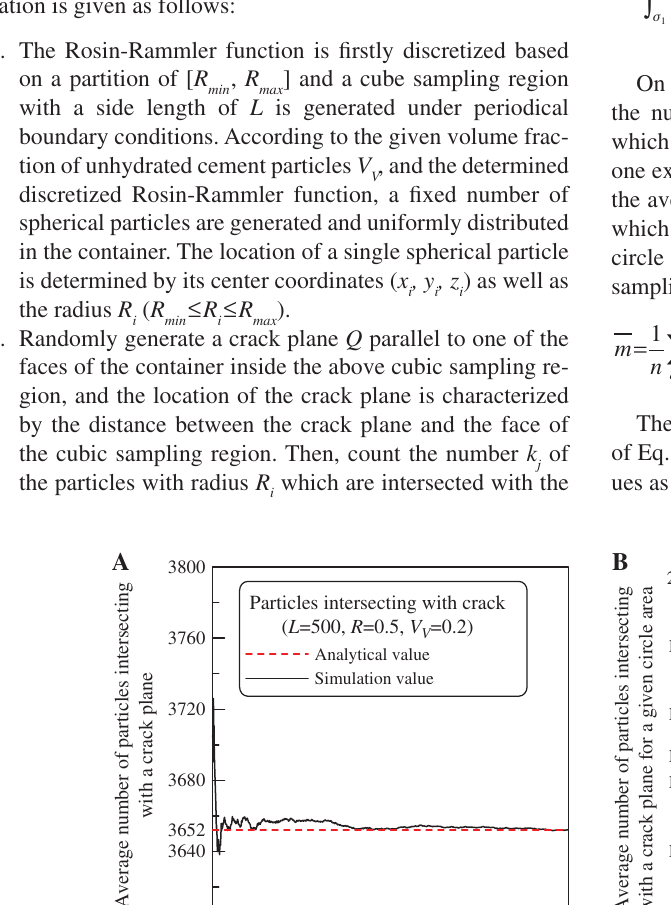
spherical particles are generated and uniformly distributed in the container. The location of a single spherical particle is determined by its center coordinates ( x